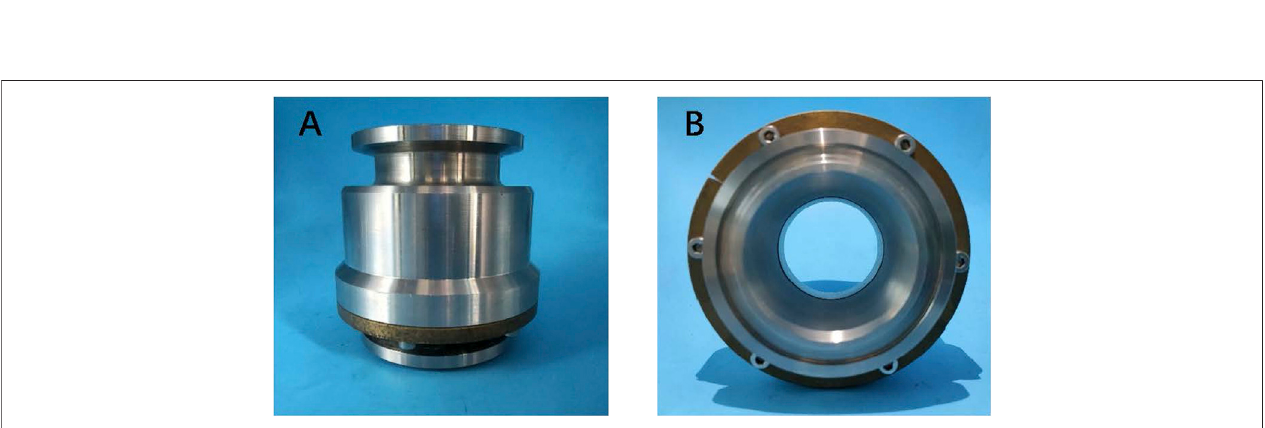
FIGURE 8 | Photo of the rotary joint. (A) The front view of the rotary joint. (B) The bottom view of the rotary joint.